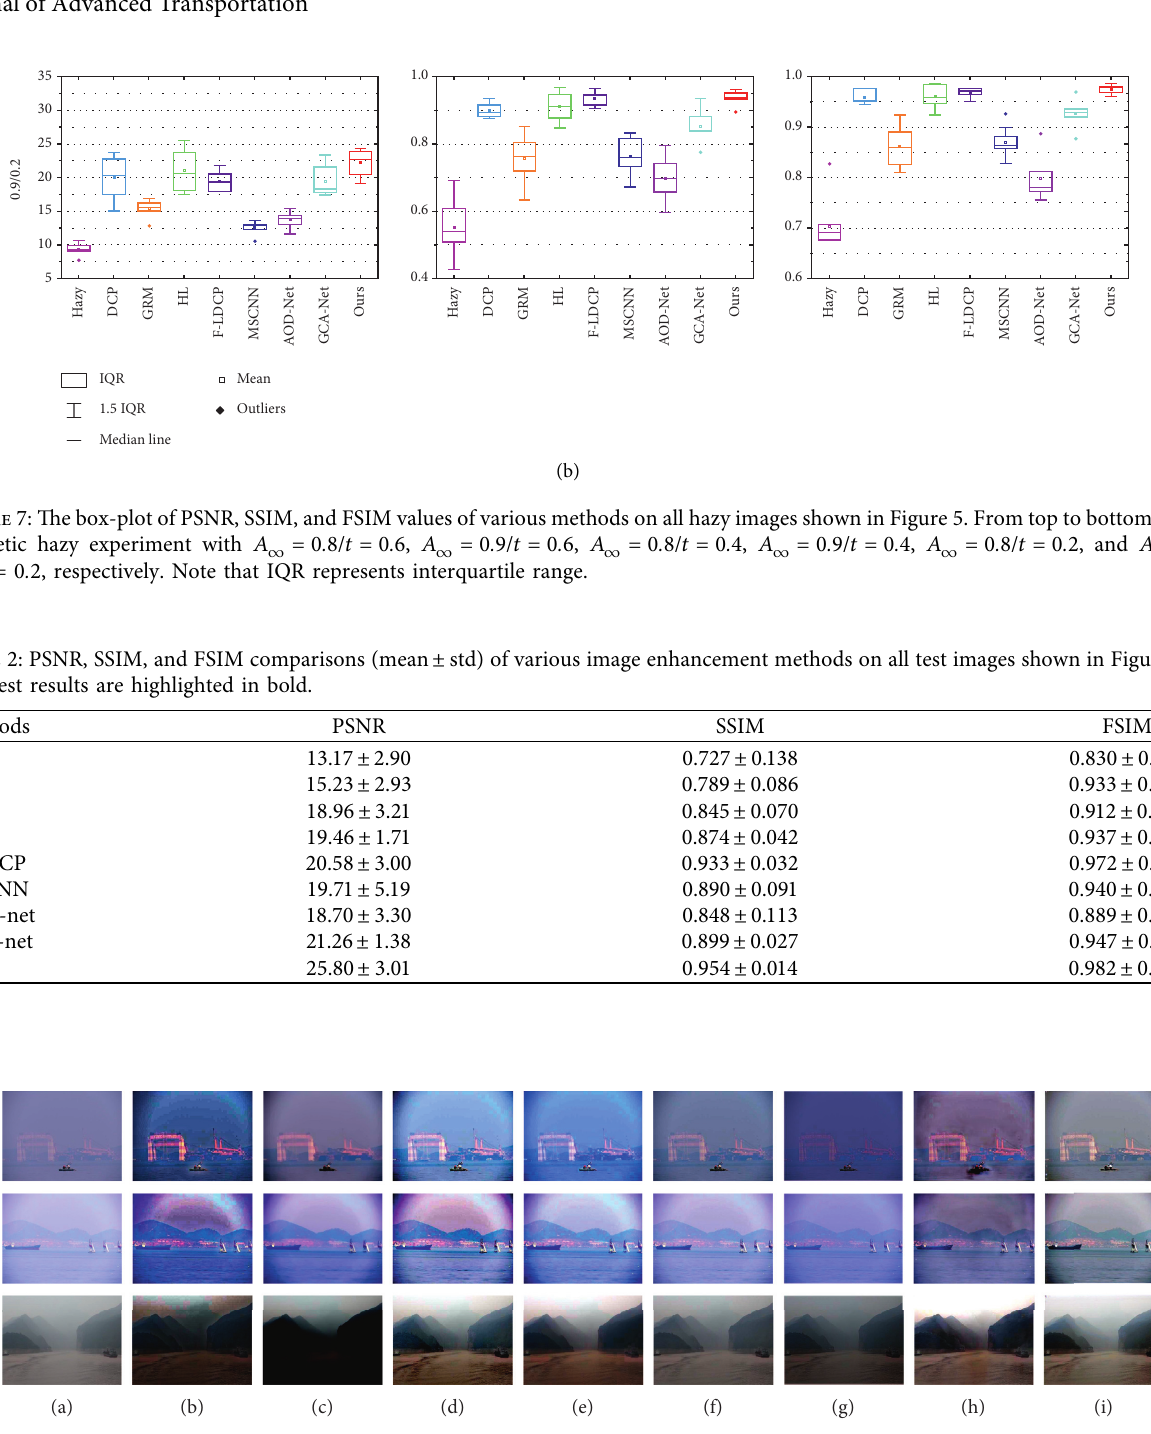
Figure 8: Comparisons of realistic experiments on three hazy maritime images. (a) Hazy, (b) DCP, (c) GRM, (d) HL, (e) F-LDCP, (f) MSCNN, (g) AOD-Net, (h) GCA-Net, and (i)